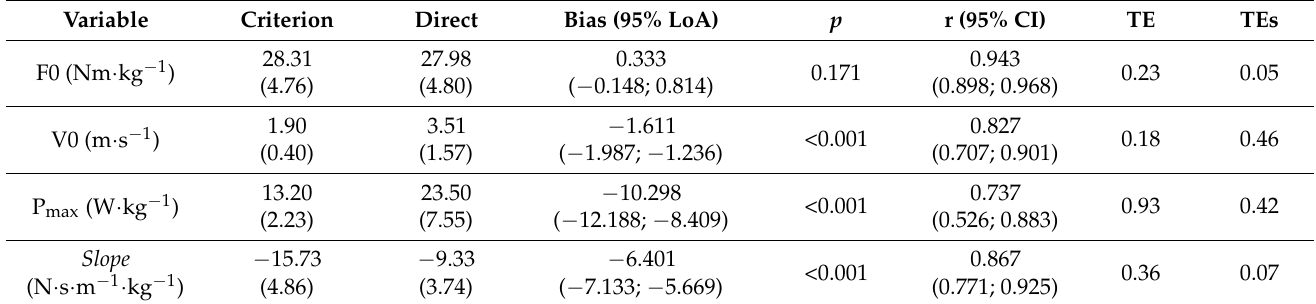
Table 5. Agreement between criterion (force plate and linear encoder setup) and direct measure (rotary encoder) for observed mean force–velocity–power output variables.